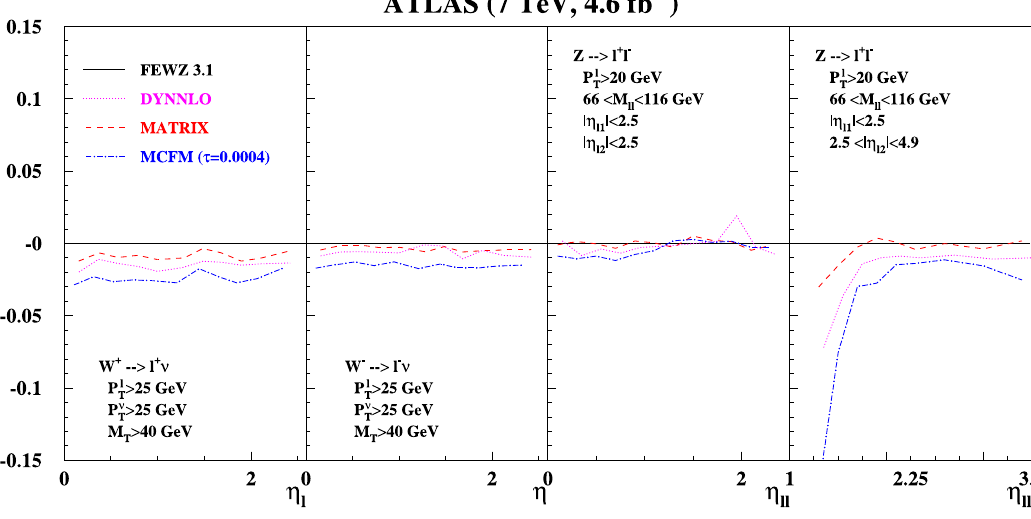
Fig. 8 Compilation of the NNLO theory predictions of Figs. 5, 6 and 7. Only the results with the smallest slicing cuts are plotted: MATRIX with r cut = 0 . 15% for W ± → l ± ν and r cut = 0 . 05% for Z → l + l − production; MCFM with τ cut = 4 · 10 −